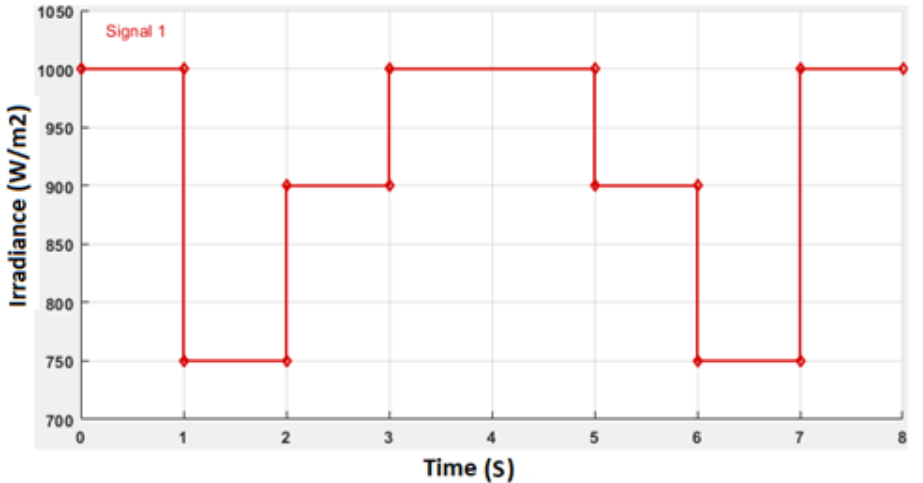
Figure 18. Input irradiation data using a signal builder block in Simulink.